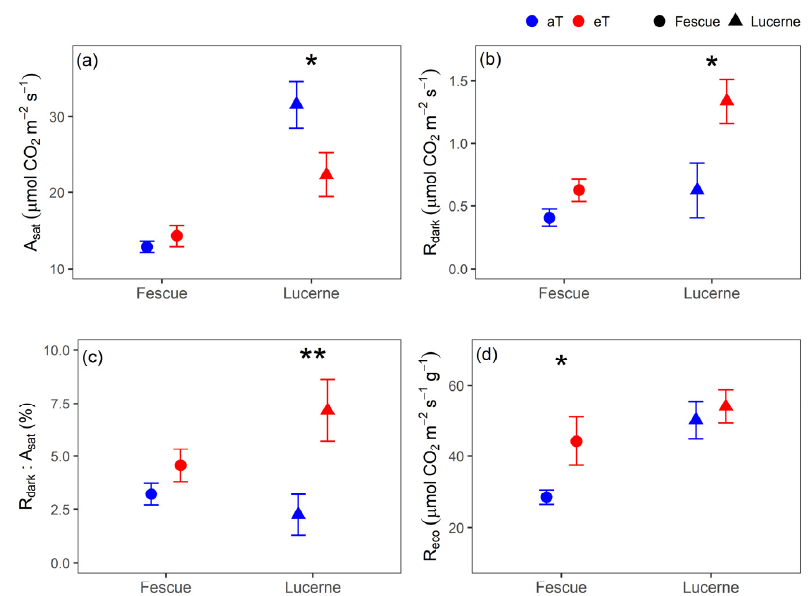
Figure 1. ( a ) Average rates of light saturated photosynthesis at ambient [CO 2 ] (A sat ), ( b ) leaf respiration during the night (R dark ), ( c ) the ratio of A sat to R dark and ( d ) total CO 2 flux from each pot per g of dry total biomass (R eco ) for tall fescue (circles) and lucerne (triangles) grown under 26 °C (aT, blue) and 30 °C (eT, red). Error bars indicate ± standard error. Statistically significant differences between temperature treatments are portrayed as * ( p < 0.05), ** ( p < 0.01). Table 1. F values of linear mixed effects models and their interactions on parameters for lucerne ( Medicago sativa ) and tall fescue ( Festuca arundinacea ), with Species (S) and growth temperature (T) as fixed effects and growth chamber as the random effect. Statistical significance denoted by * ( p < 0.05), ** ( p < 0.01) & *** ( p < 0.001).